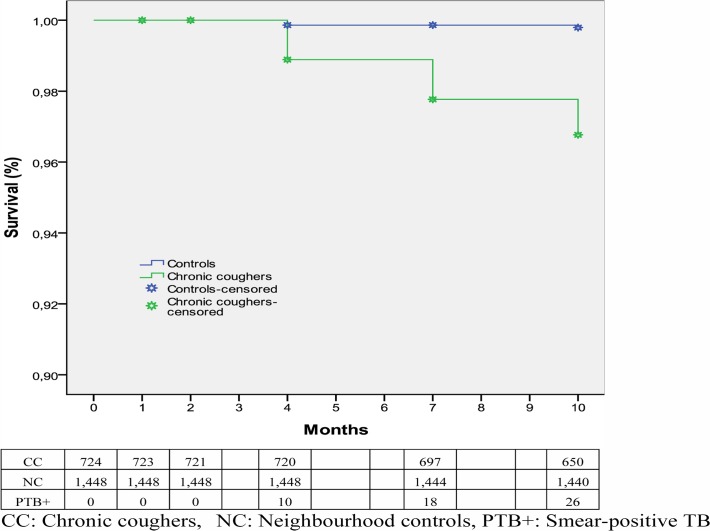
TB-free survival of the study participants during September 2011 and June 2012 in Dale district, South Ethiopia.